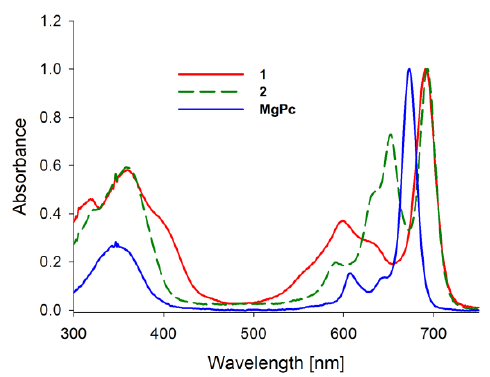
Figure 2. The UV-vis absorption spectra of studied macrocycles MgPc, 1, 2.